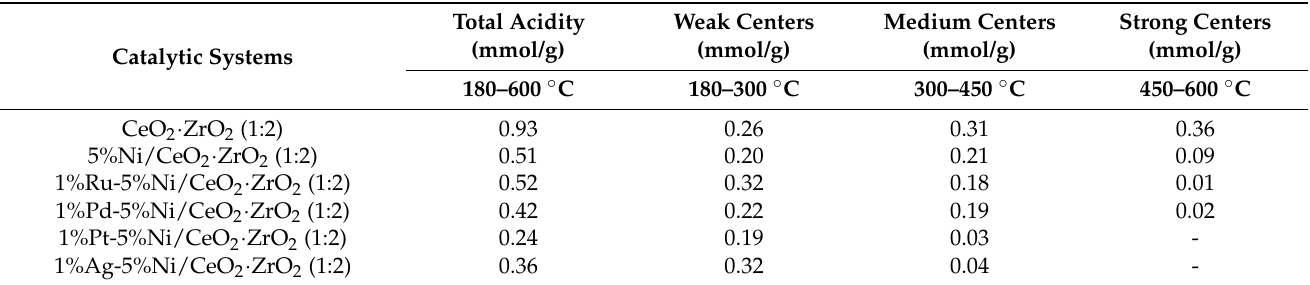
Table 4. The surface acidity of the studied catalytic materials expressed as the amount of NH 3 adsorbed on the surface calcu- lated from the results recorded during TPD-NH 3 measurements for the support, monometallic Ni and bimetallic catalysts.